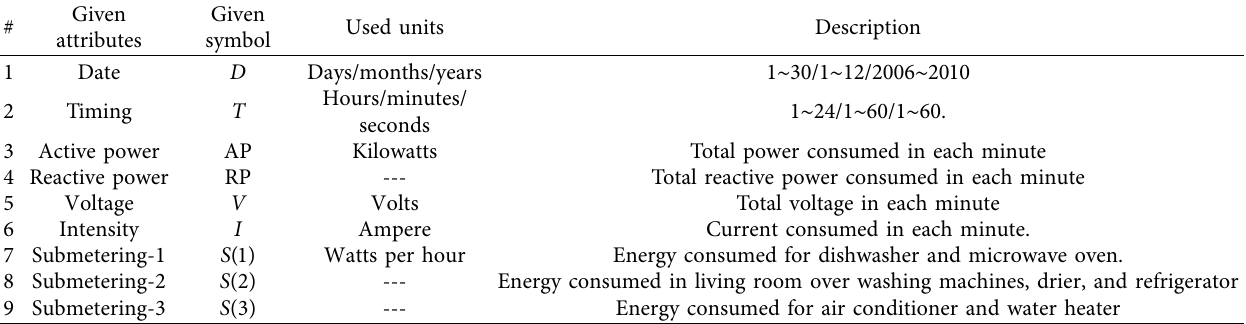
Table 1: Household power dataset [43] with its attribute description.